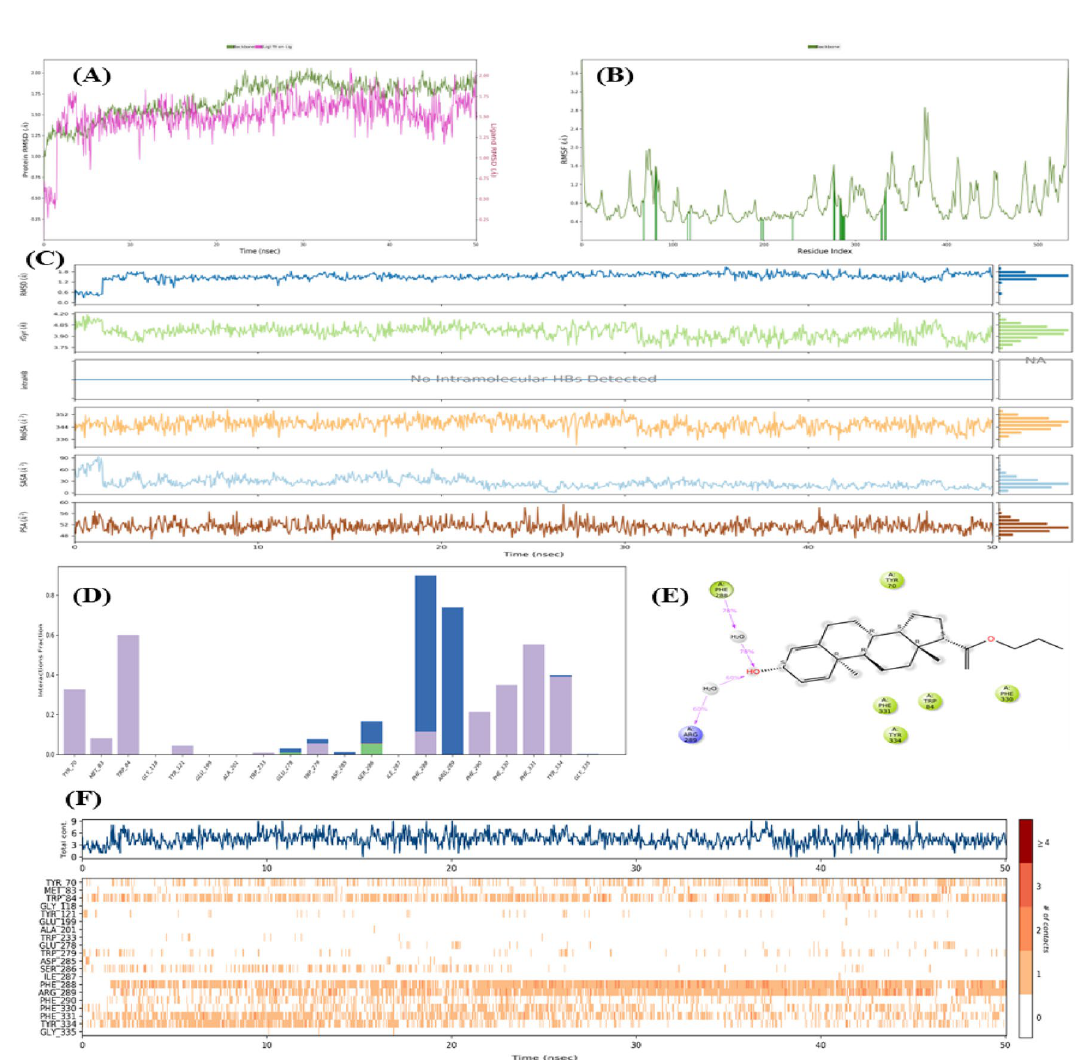
Figure 6. Molecular dynamic simulation of AChE enzyme (PDB code: 1EVE) and A-1 complex studied for 50 ns, where ( A : RMSD protein ligand complex; B : RMSF plot of amino acids of proteins; C : RMSD, rGyr, Intra HB, MoISA, SASA and PSA plot of A-1; D : Histogram showing the type of protein ligand interaction, E : 2D interaction diagram of A-1 with protein’s amino acid residues and, F : Count of protein ligand contact during 50